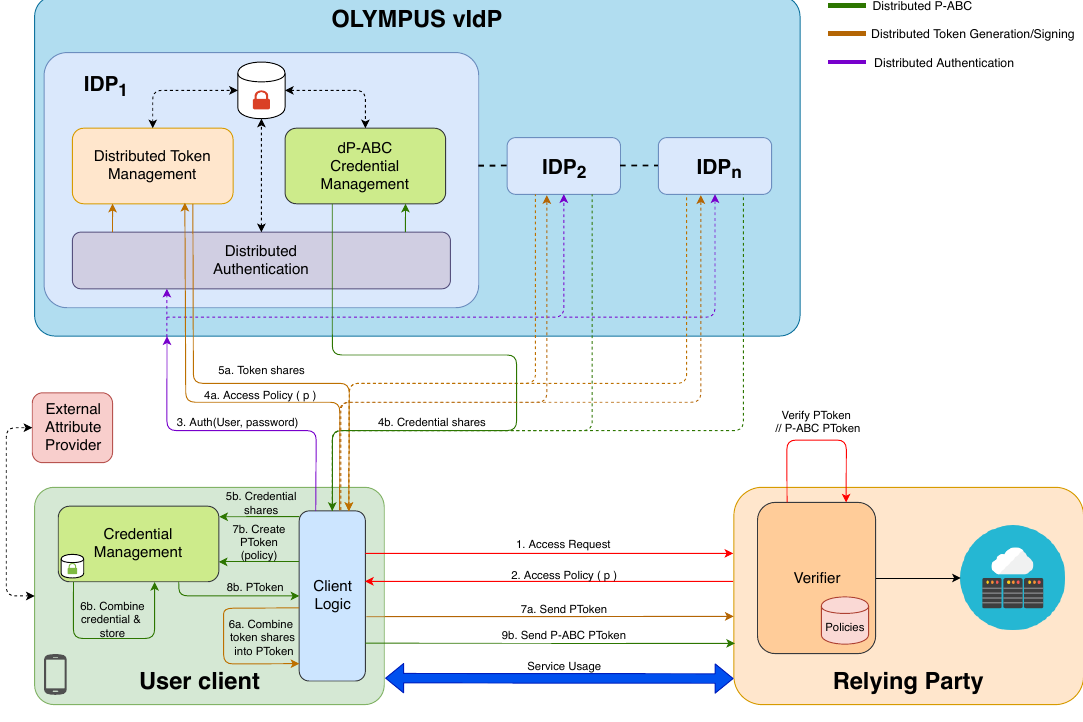
Figure 2. OLYMPUS